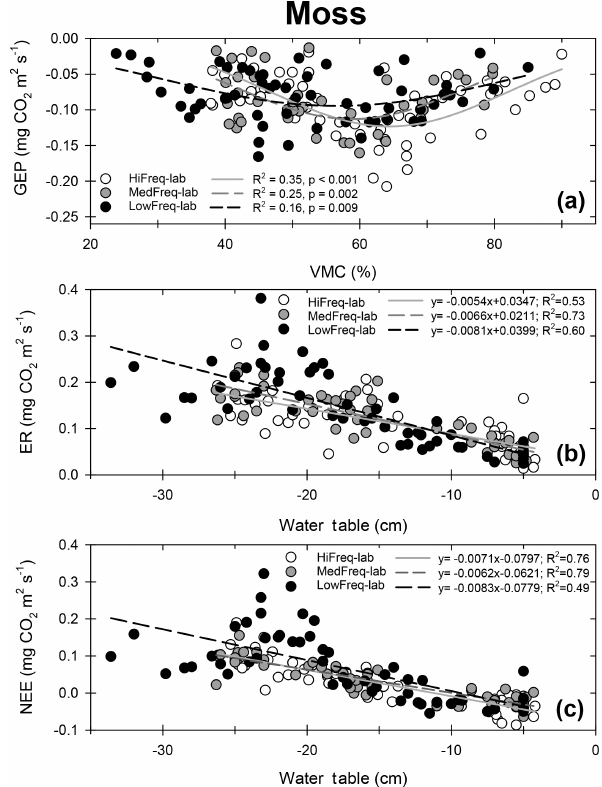
Figure 5. Hydrologic controls on CO 2 exchange in S. capillifolium - dominated monoliths, depicting relationships in (a) GEP, (b) ER, and (c) NEE between rainfall frequency treatments. Relationships in (a) are unimodal with indicated correlation coefficients and sig- nificance. Relationships in (b) are linear and are indicated with cor- relation coefficients. All regressions in (b) were statistically sig- nificant ( p < 0 . 001). Relationships for HiFreq-lab and MedFreq- lab treatments in (c) are second-order polynomial; relationship for LowFreq-lab is third-order polynomial with indicated correlation coefficients and